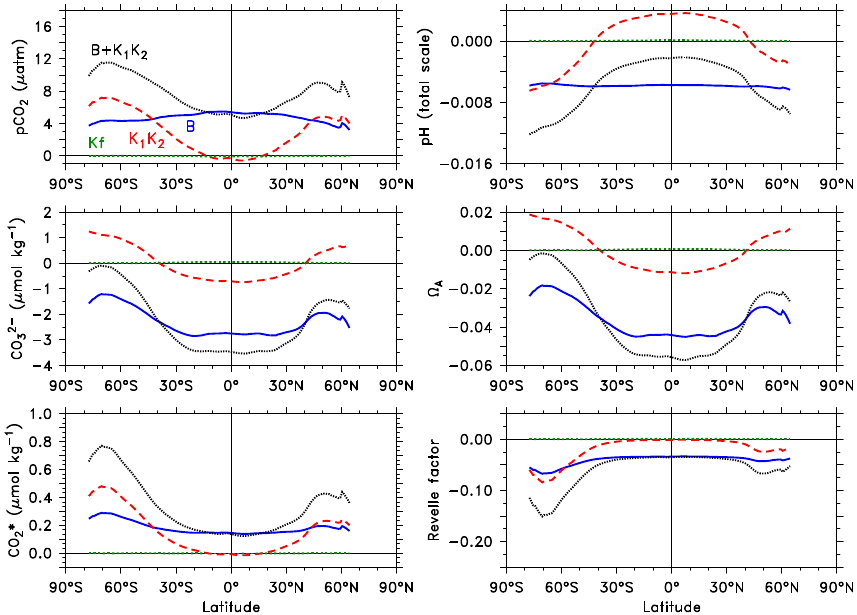
Figure 8. Changes in zonal means of computed variables due to replacing best-practice recommendations with other options: (1) the Lee et al. (2010) formulation for the total boron-to-salinity ratio (blue B), (2) the Millero (2010) formulations for K 1 and K 2 (red, K 1 K 2 ), and (3) the Dickson and Riley (1979) formulation for K F (green K F ). Absolute differences are shown relative to (1) Uppström (1974), (2) Lueker et al. (2000), and (3) Perez and Fraga (1987). Also indicated is the sum of the first two changes